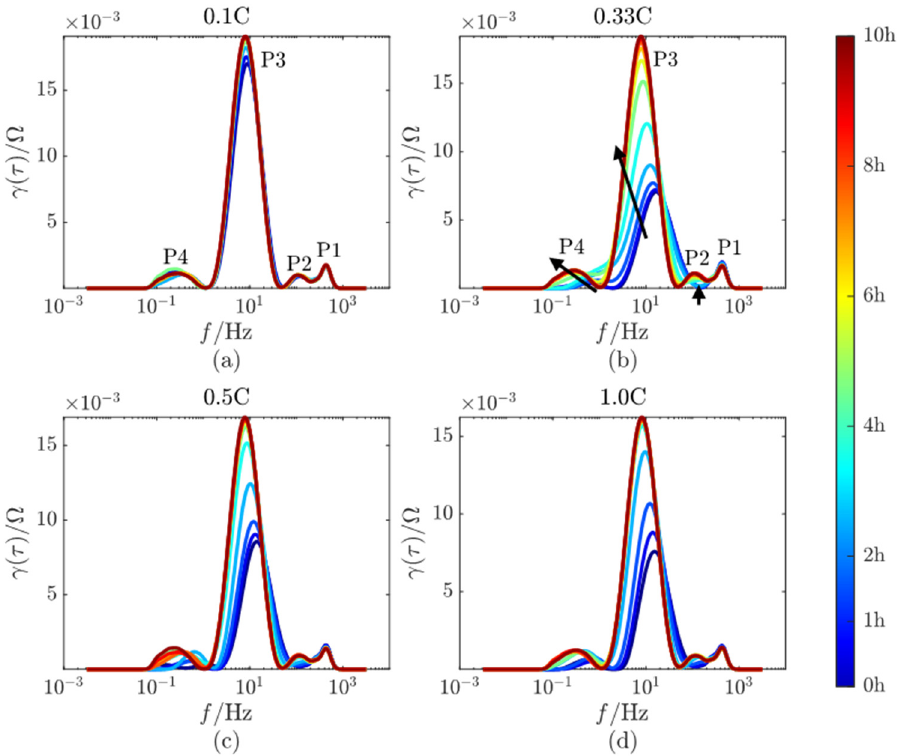
Figure 3. The DRT results of ( a ) experiment #1-1; ( b ) experiment #1-2; ( c ) experiment #1-3; ( d ) experiment #1-4.